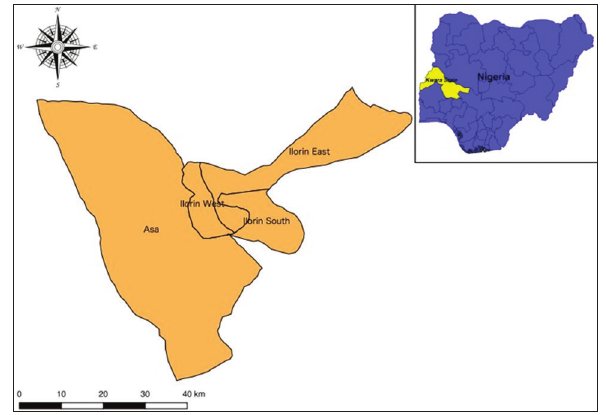
Figure-1: Map of Kwara Central (the study location). The insert map shows Kwara State within Nigeria (Designed using QGIS Version